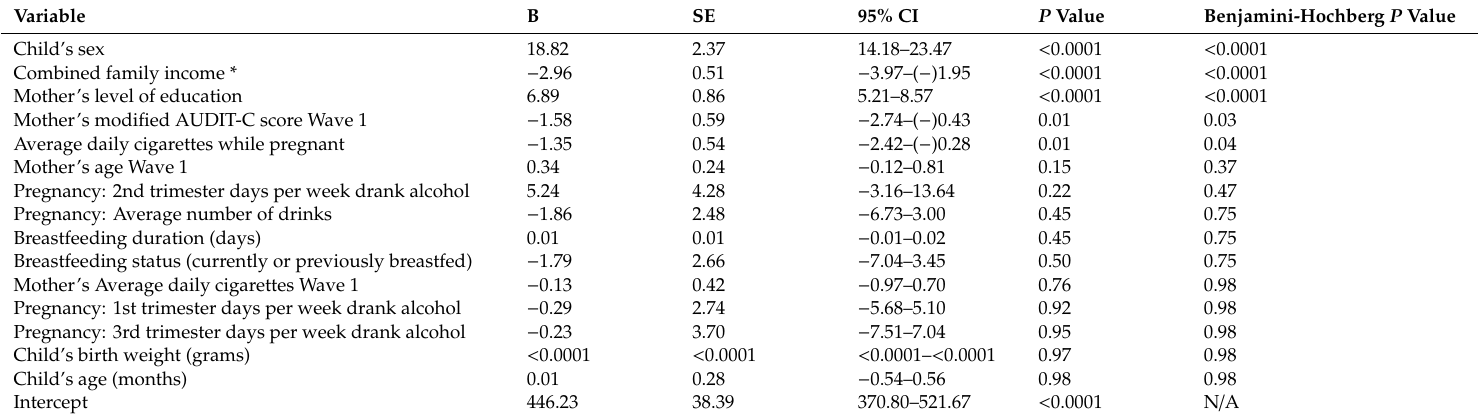
Table 5. Grade 5 NAPLAN spelling scores (babies who had been breastfed at any time).